Question: What type of chart is this?
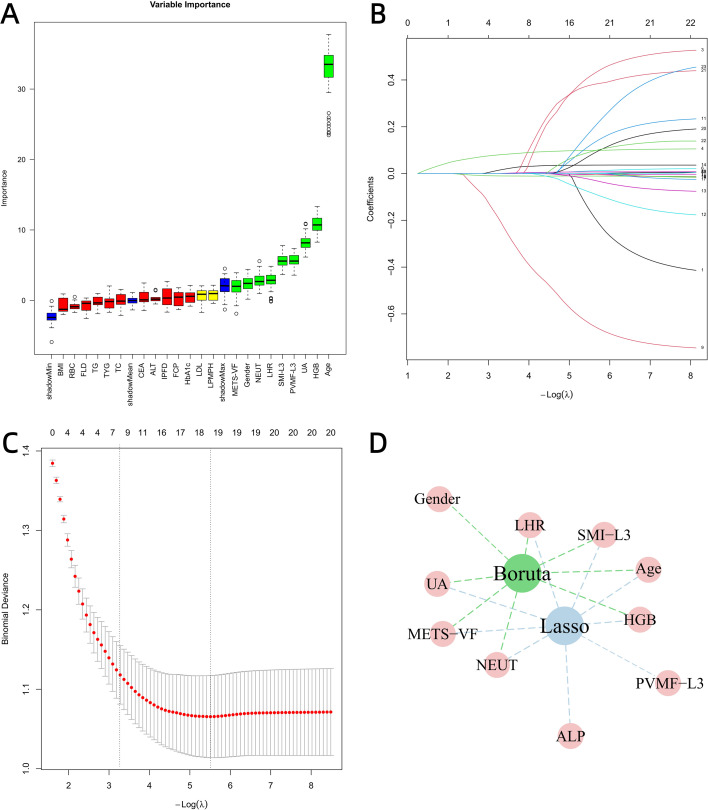
Answer: box